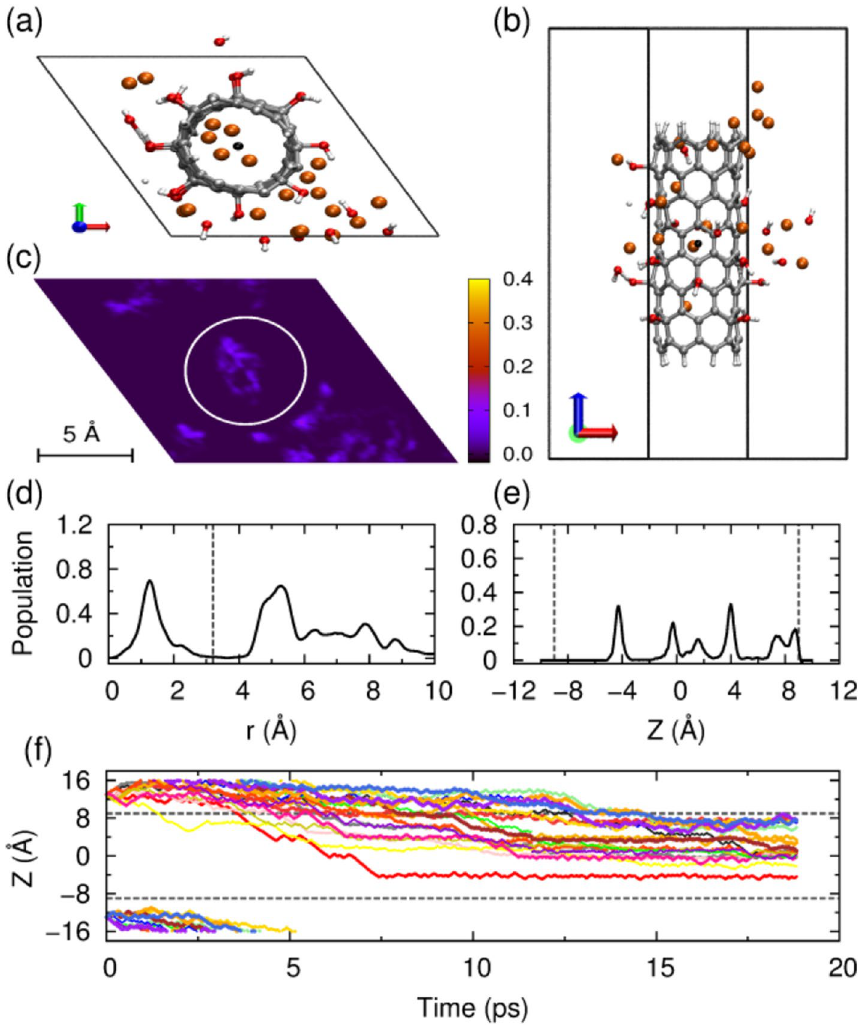
Figure 4. Behavior of the twenty Li ions intercalating and diffusing into the bundle of the –OH functionalized CNTs, simulated in a hexagonal box with dimensions of 15.0 × 15.0 × 32.0 Å 3 . ( a ) Typical snapshot of the unit cell, top view. ( b ) Side view. ( c ) Distribution of the Li ions in the x–y plane. ( d ) Radial distribution of the Li ions. ( e ) Axial distribution of the ions within CNT. (f) The z-position as a function of simulation time (ps) for each Li ion. The pictures of ( a – c ) are generated by VMD 1.8.3 software. URL link: http:// www. ks. uiuc. edu/ Resea rch/ vmd/. The plots of ( d – f ) are generated by gnuplot 5.0 software. URL link: http:// www. gnupl ot.